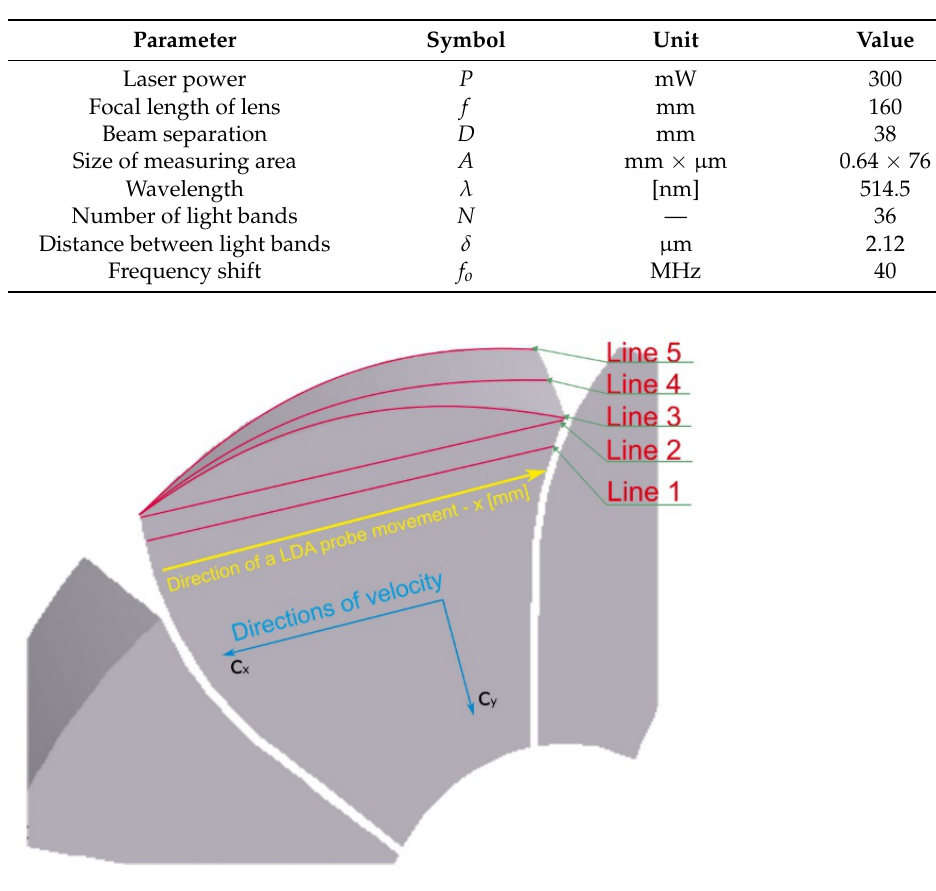
Figure 8. Measurement cross-sections for the LDA method. The “air bubble” method was used for the visualization tests. The diagram of supply- ing air to the flowing liquid is shown in Figure 9.